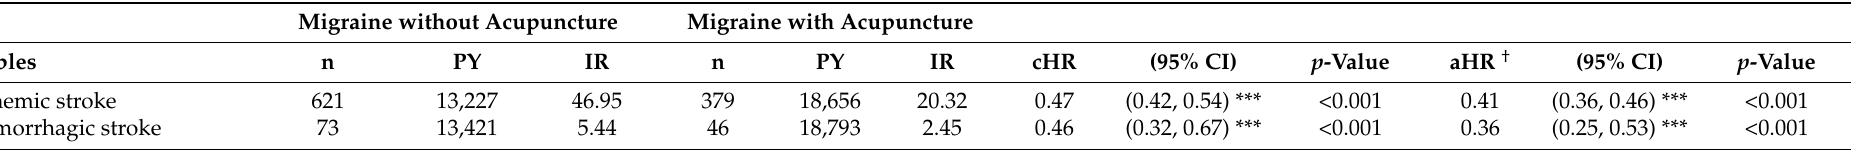
Table 4. Incidence rates, hazard ratios, and confidence intervals of ischemic and hemorrhagic strokes in patients with migraines who did and did not receive acupuncture